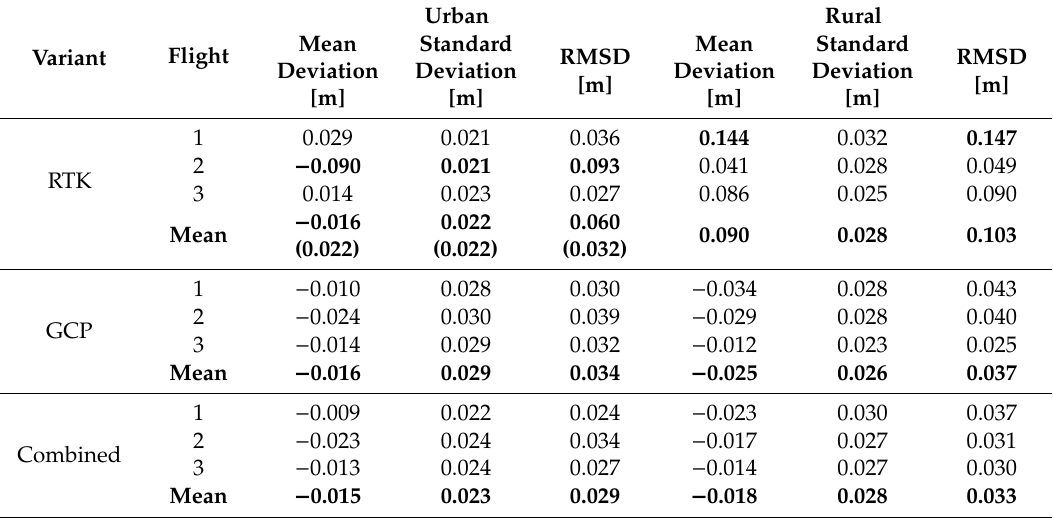
Table 8. Results of the accuracy assessment of the vertical